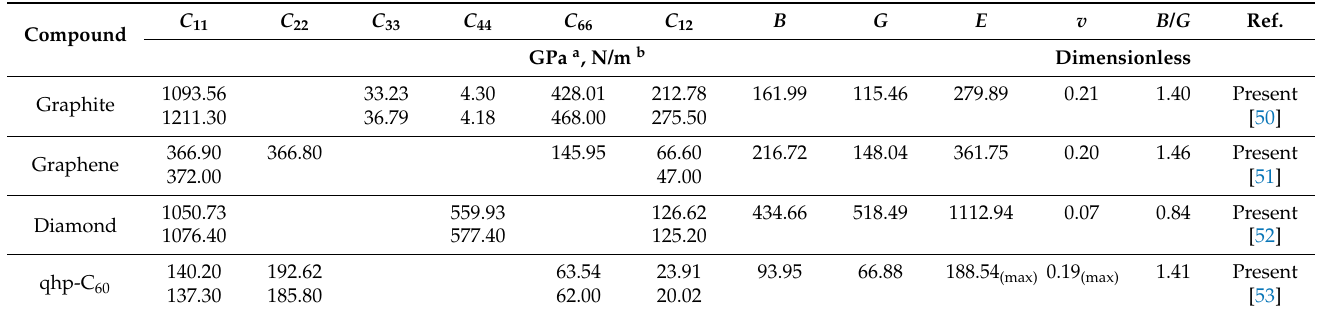
Table 2. Elastic constants, bulk modulus, shear modulus, Young’s modulus, and Poisson’s ratio of the four carbon materials.